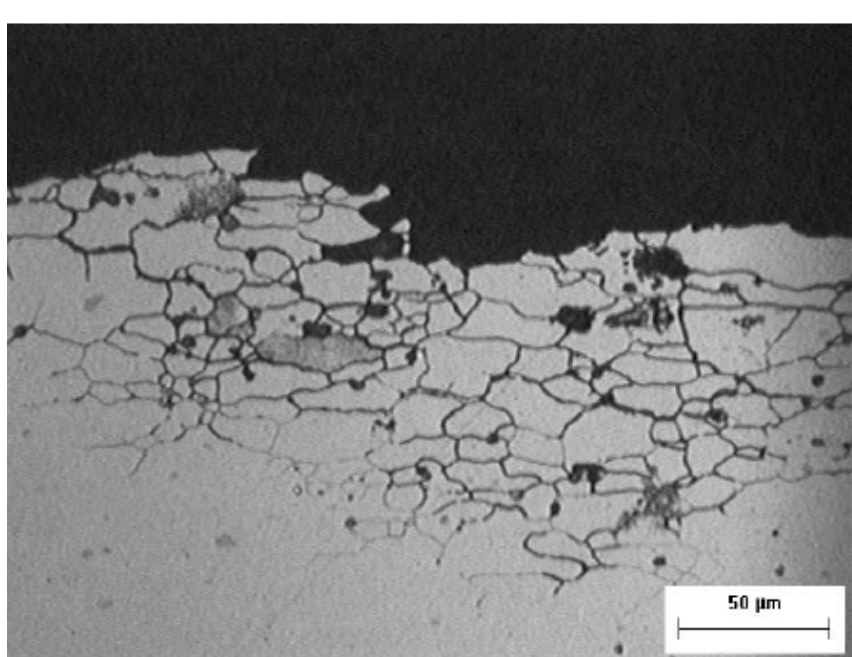
Figure 4. Example of Intergranular Corrosion [13].